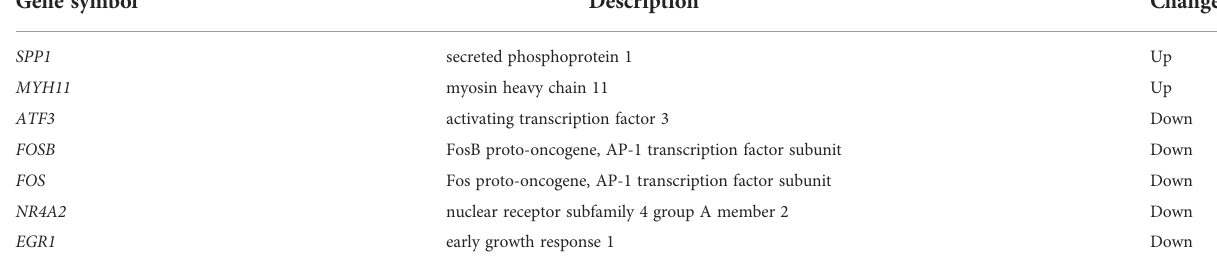
TABLE 4 The gene cluster in the intersection of